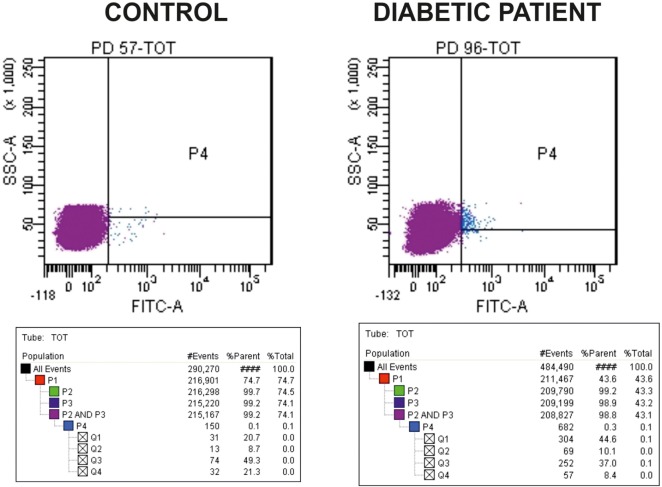
Representative dot-plots of a control subject [left panel, circulating endothelial progenitor cells (cEPCs) = 8.7] and diabetic patient belonging to the “<20 y T1DM” cohort (right panel, cEPCs = 10.1). The cEPC count was performed as described in the Section “Materials and Methods” and gating a population with morphological characteristics between lymphocytes and monocytes (evaluated through side scatter and forward scatter). In the final plots, the cEPC count of each sample is reported in Q2 that is a part of P4 quadrant. “cEPC counts” refers to the absolute cEPC number per 2 × 105.